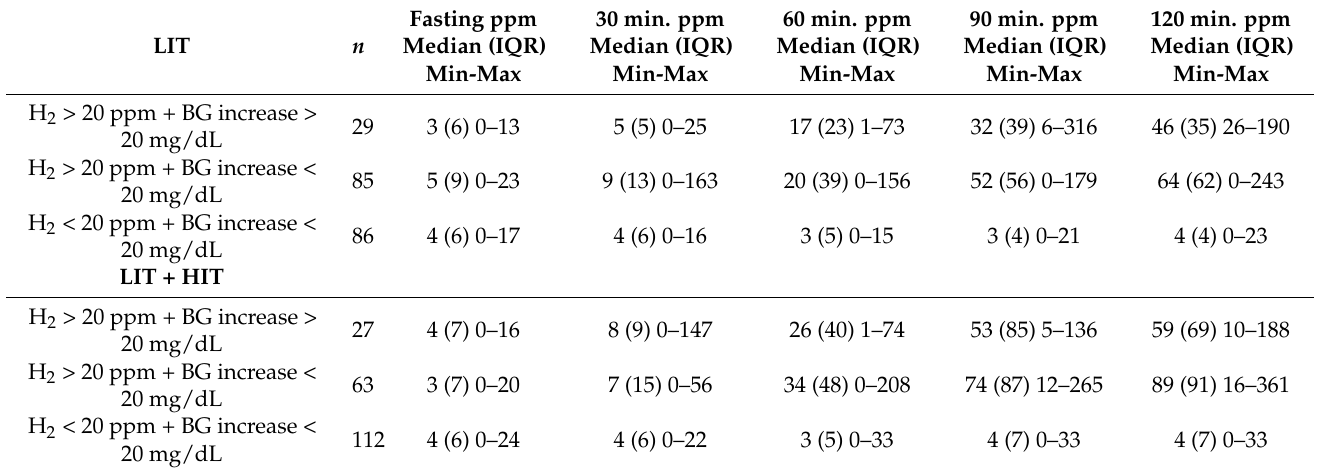
Table 2. Median parts per million (ppm) of exhaled H 2 during lactose breath tests in 402 LIT patients.